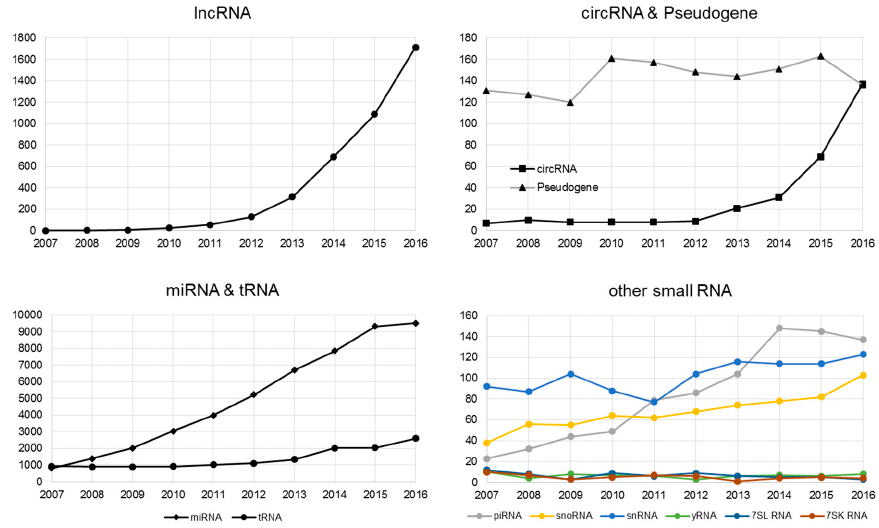
Figure 2. Sharp increase of publications focused on non-coding RNA by PubMed searches. Table 1. lncRNA databases.